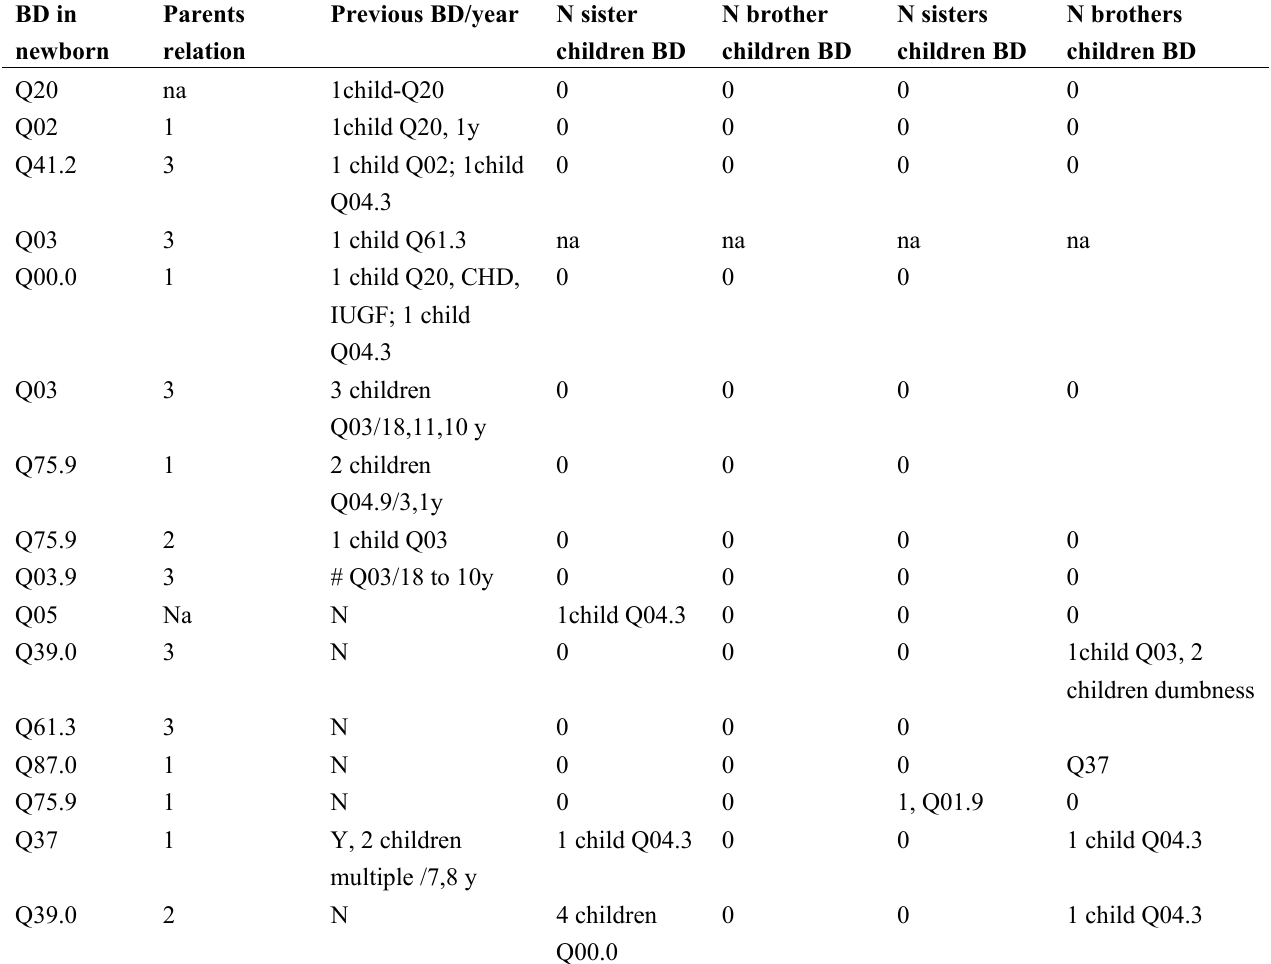
Table 5. Listing of couples with BD and PBD and/or BD in relatives. N, none; na. not available. Parent relation: 1-first cousins, 2-extended family,